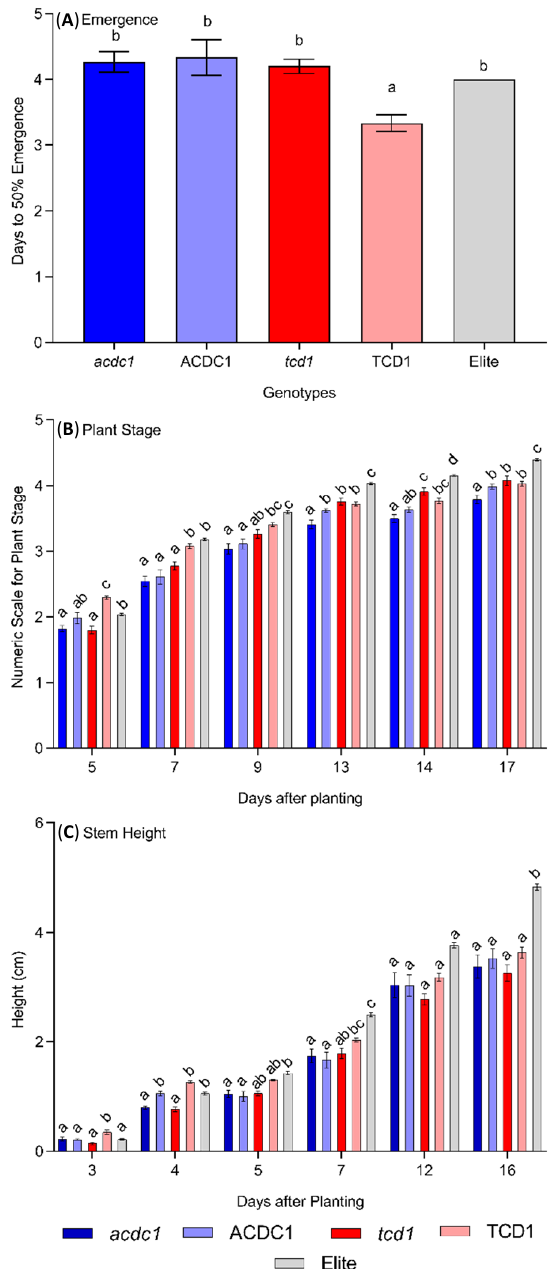
Figure 1. Seedling growth of sorghum genotypes (wild type parent, adult cyanide deficient 1 ( acdc1) mutant, acdc1 sibling (ACDC1), totally cyanide deficient class 1 ( tcd1 ) mutant and tcd1 sibling (TCD1)) recorded for 17 days after sowing in soil; ( A ) days to 50% emergence; ( B ) plant stage converted to a numeric scale; ( C ) plant height in cm. Each data point is mean of at least 250 replicates ± 1 standard error. Bars with the same letter at one timepoint are not significantly different from each other ( p > 0.05; Tukey’s HSD pairwise test).